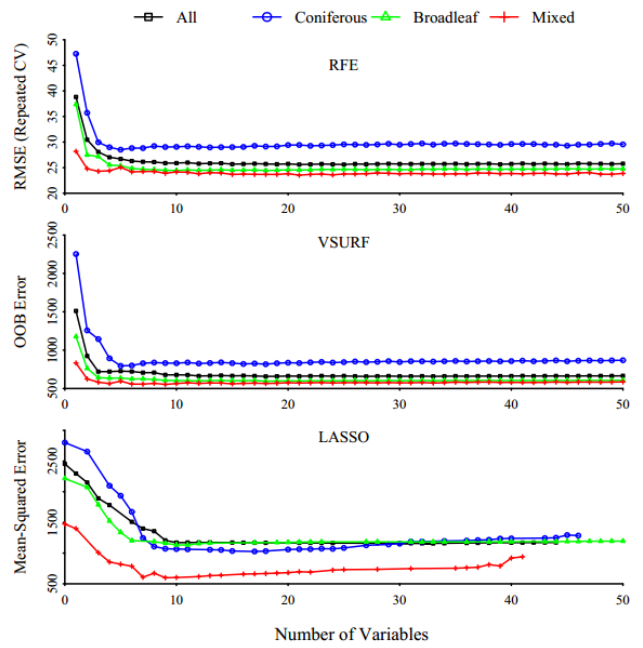
Figure 3. The changes in the accuracy of three feature selections (recursive feature elimination (RFE), least absolute shrinkage and selection operator (LASSO), variable selection using random forests (VSURF)) with the number of variables. Each curve represents an independent model, and different colors indicate different forest types.